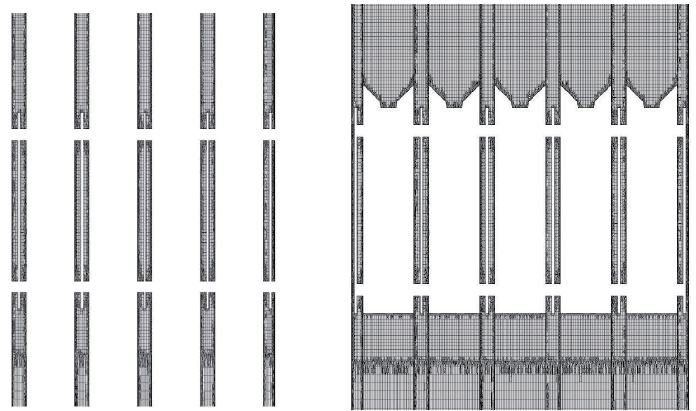
Figure 10: Subchannel mesh distribution with near-wall mesh detail.